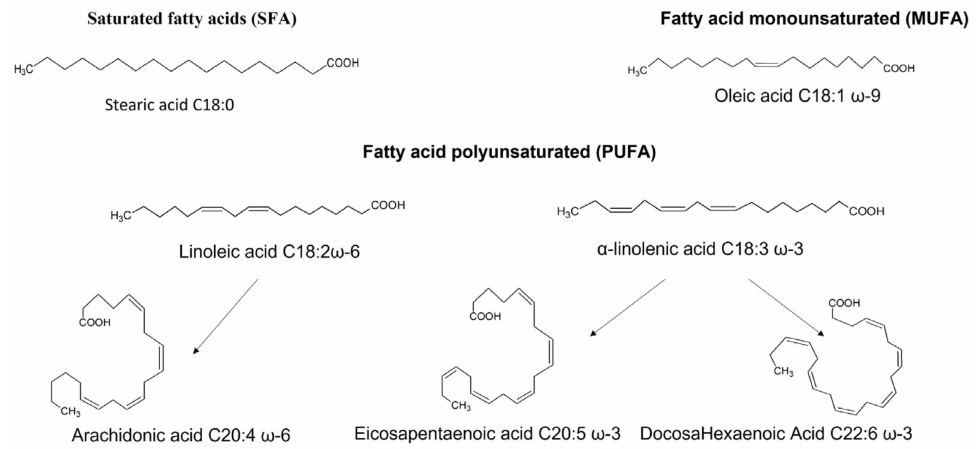
Figure 1. The different families of fatty acids and their main members. Fatty acids are classified according to the saturation or unsaturation of the carbon chain. There are saturated fatty acids (SFA), monounsaturated fatty acids (MUFA), and polyunsaturated fatty acids (PUFA). Among the latter, we distinguish between omega-3 and omega-6. Docosahexaenoic acid belongs to the omega-3